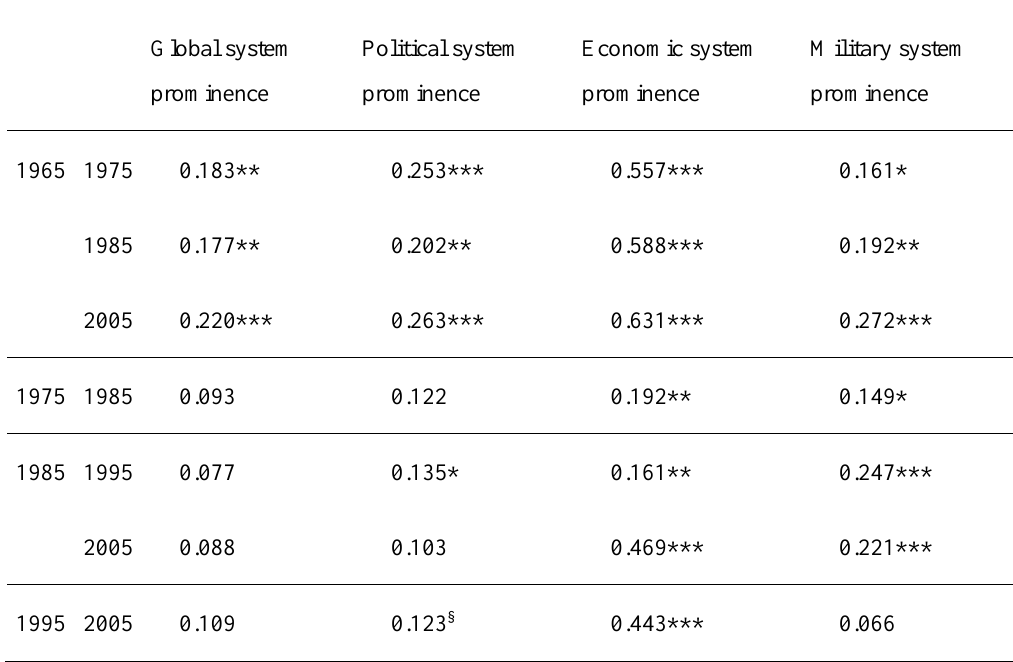
Table 1: Kolmogorov-Smirnov Tests for Comparisons of System Prominence Indicators in